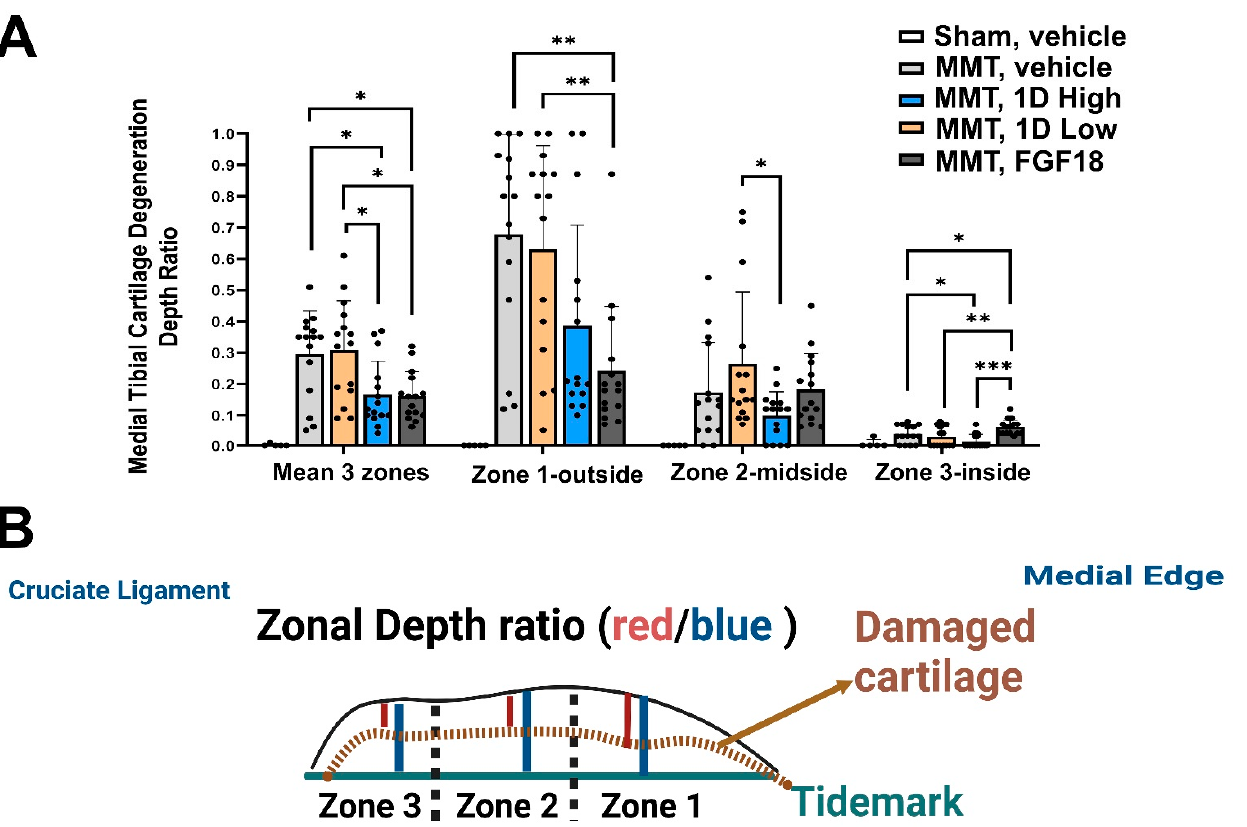
Figure 5. Histopathology for post-MMT Medial Tibial Degeneration Depth ratio. The zonal depth ratio of toluidine-stained sections is shown for all five groups ( A ), per zone of the medial tibial plateau and for the mean of the three zones. ( B ) The lesion depth ratio is calculated by dividing the depth of a zonal lesion (red line from dashed brown line denoting damaged cartilage) by the thickness of articular cartilage from the tidemark (blue line). The deeper the lesion is, the higher the death ratio. Statistical significance between treatments and control was examined via Kruskal–Wallis test with a Dunn’s post hoc analysis for scored (non-parametric) parameters, considering * p < 0.05 to be statistically significant. ** p < 0.01; *** p < 0.001. Sham, n = 5; MMT-Vehicle n = 15; MMT-1D, low dose 8 µg n = 15; MMT-1D, high dose 24 µg n = 15; and MMT-FGF18 3 µg n = 15.